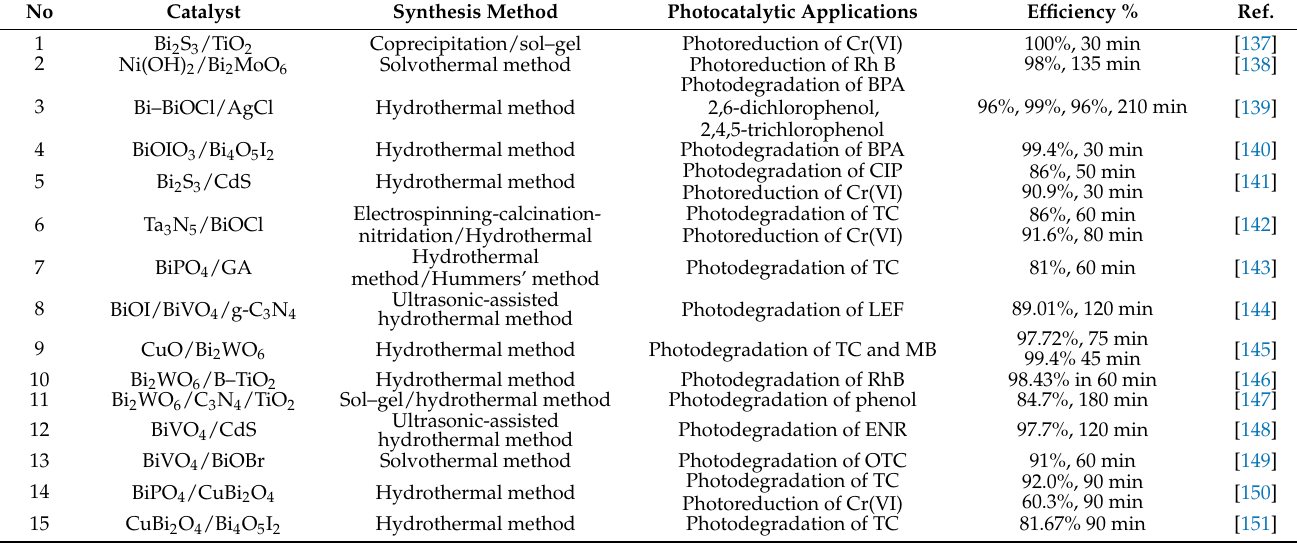
Table 1. List of bi-based semiconductor heterojunction